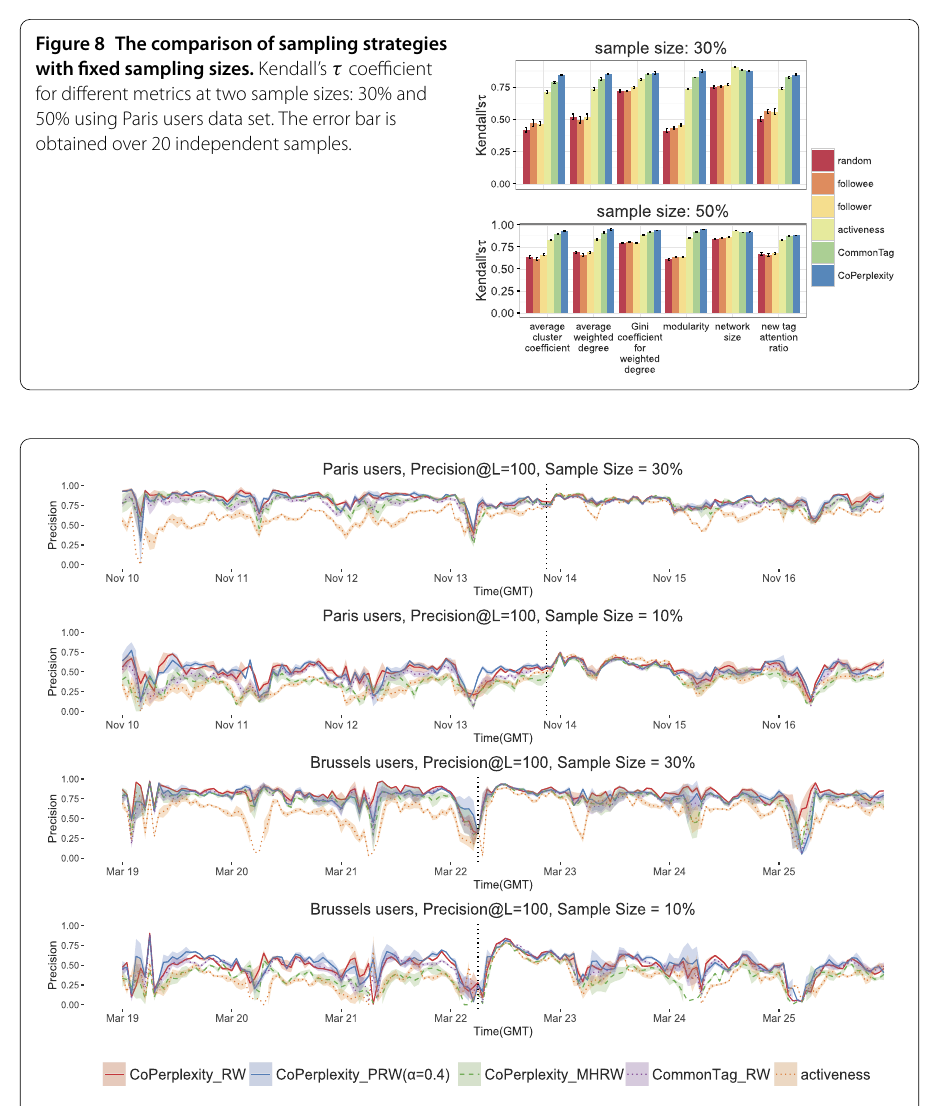
Figure 9 Effectiveness of preserving the most attended hashtags. The plots show the performance, calculated based on precision@L with L = 100, for preserving the most attentive hashtags using different sampling methods, tested on the Paris and Brussels datasets. The vertical dotted lines indicate the time of the events. The performance is reported for each hour within the entire week centered on the event happening time (three days before and three days after the attacks). The three methods, CommonTag_RW , CoPerplexity_RW , and CoPerplexity_PRW are more robust under various